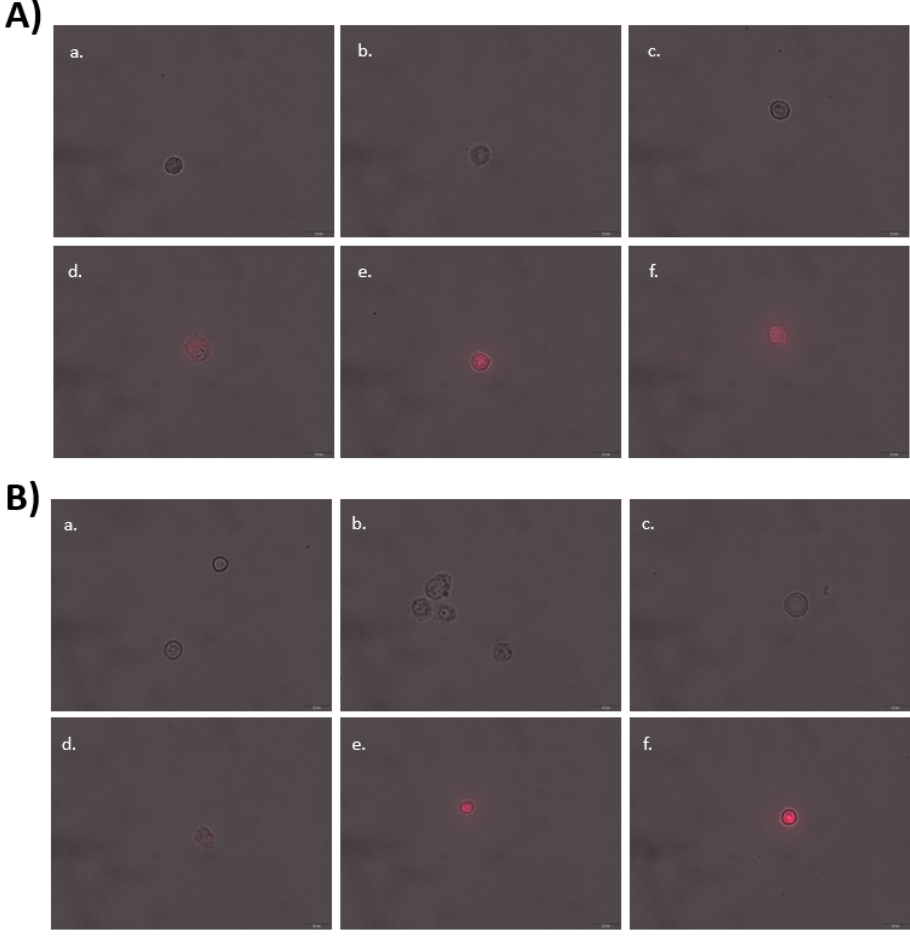
Figure 4. Visualization of Nile Red with and without 24 or ML-C 12 in ( A ) JAWSII and ( B ) J774A.1. Cells were treated for 1 h without ( a – c ) or with ( d – f ) Nile Red. Images were obtained using an inverted Olympus IX73 microscope and are merged with phase contrast and TRITC, 400× magnification. Cells were exposed at 540 nm for 2s. Scale bar, 20 μ m. ( a ) negative control; ( b ) ML-C 12 ; ( c ) 24 ; ( d ) negative control with Nile red, ( e ). ML-C 12 with Nile Red; ( f ) 24 with Nile Red.